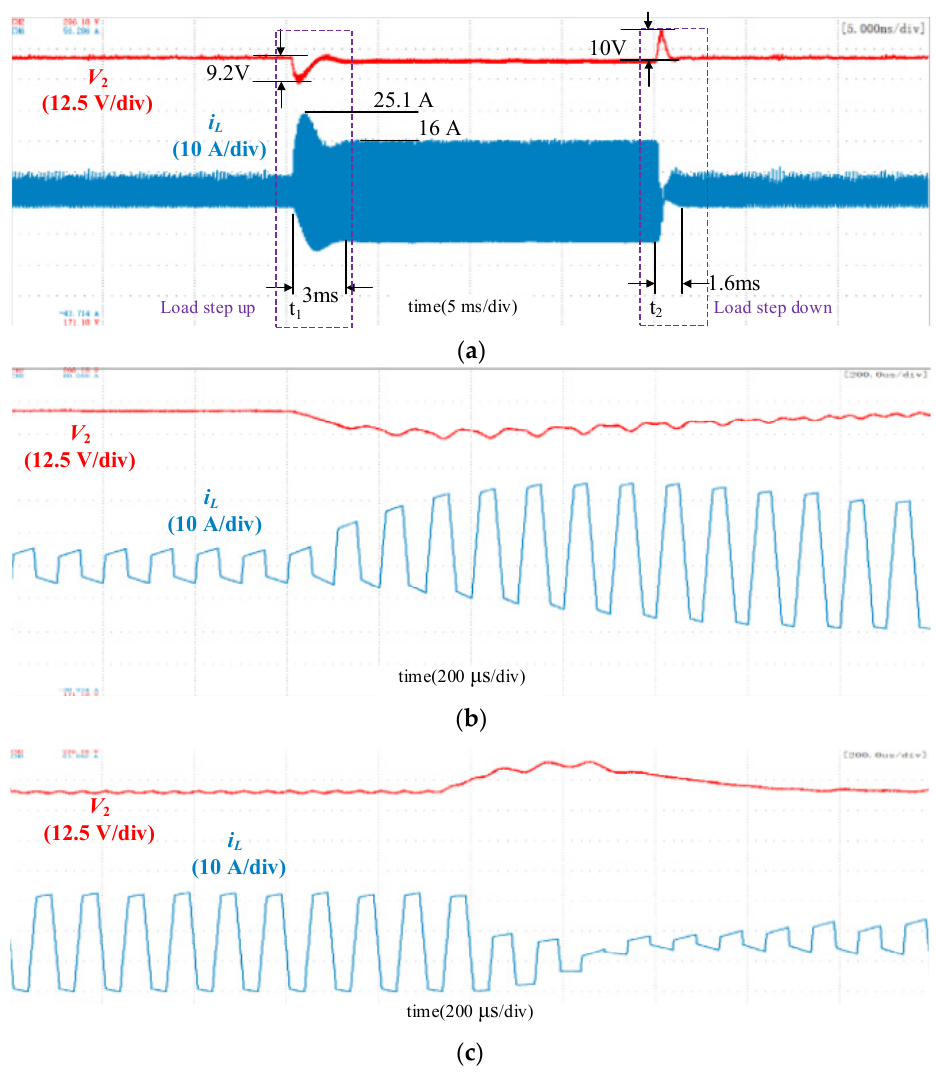
Figure 10. Waveforms using the conventional single-loop control. ( a ) Overall waveforms; ( b ) Zoomed-in waveforms during the load increase; ( c ) Zoomed-in waveforms during the load decrease.